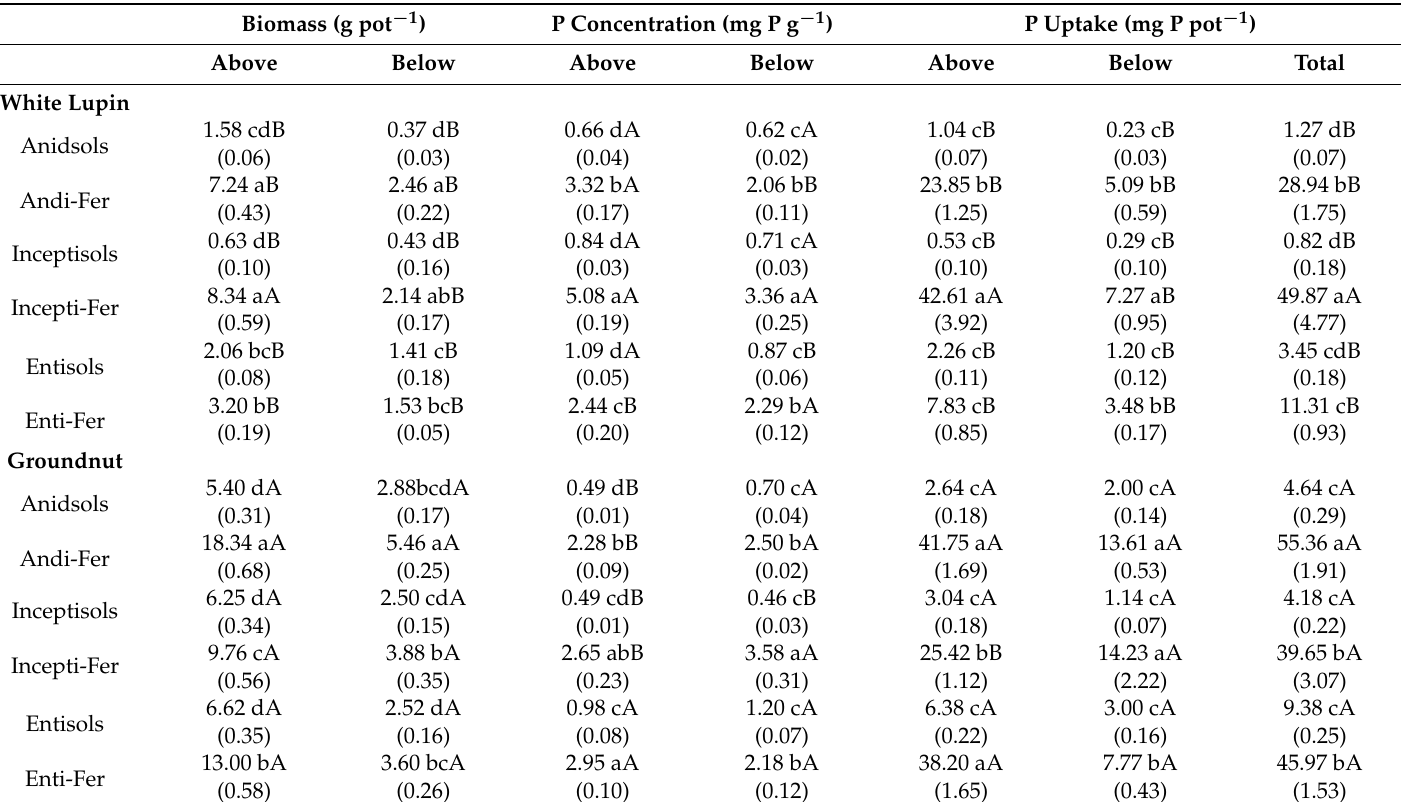
Table 2. Plant biomass, P concentration, and P uptake after the pot